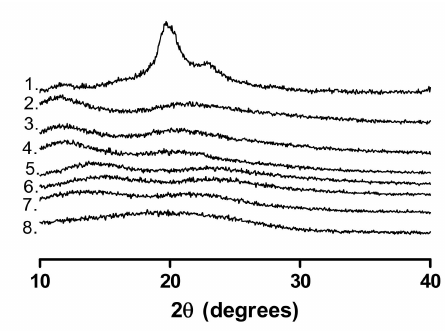
Figure 3. pXRD patterns of the polymers used. 1. PVAlcohol, 2. PVP90, 3. PVP30, 4. PVP17, 5. VP:VA 7:3, 6. VP:VA 3:7, 7. PVAcetate, 8.